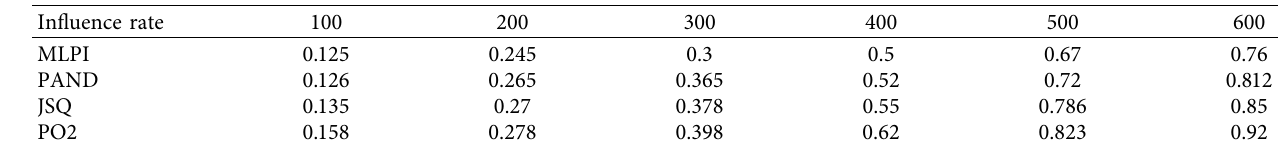
Figure 6: Network load impact rate. Table 4: Impact rate test data.